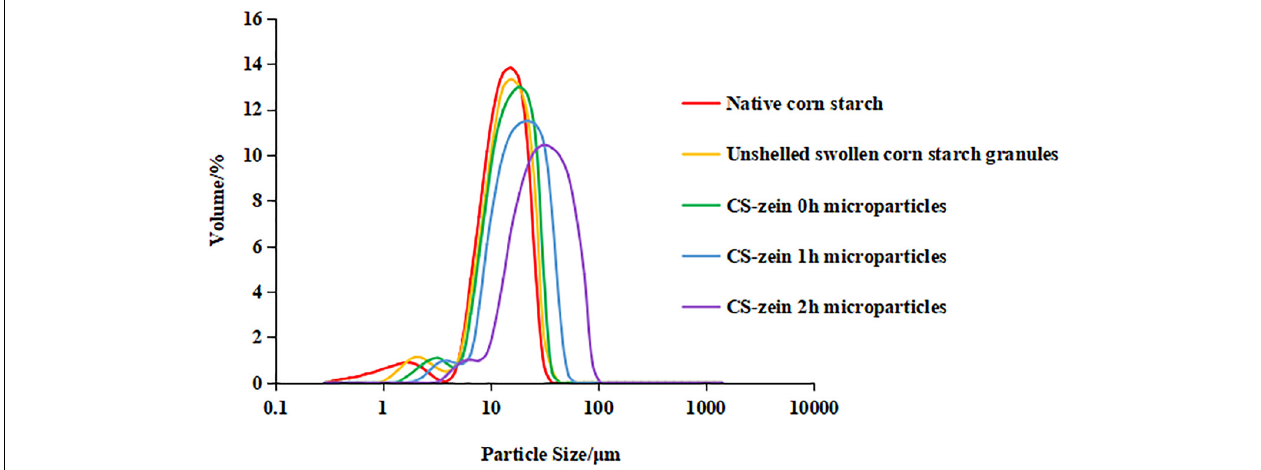
FIGURE 4 | Particle size distribution of native corn starch, unshelled swollen corn starch granules, and core-shell starch/zein microparticles crosslinked by TGase for different times (0, 1, and 2 h). TABLE 1 | The pertinent parameter of particle size distribution of native corn starch, unshelled swollen corn starch granules, and core-shell starch/zein microparticles crosslinked by TGase for different times (0, 1, and 2 h). Sample d(4,3)/ µ m